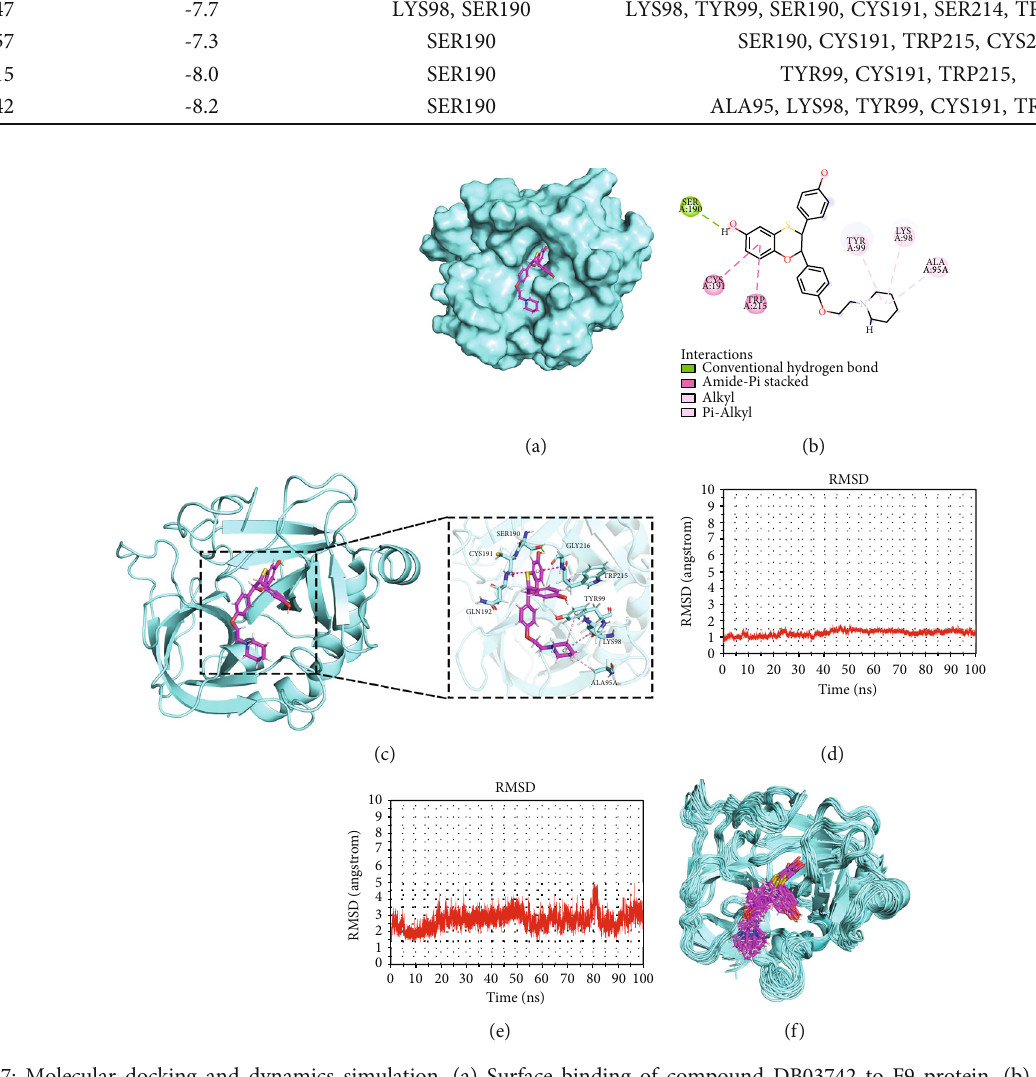
Figure 7: Molecular docking and dynamics simulation. (a) Surface binding of compound DB03742 to F9 protein. (b) 2D diagram of interaction between compound DB03742 and F9 protein. (c) 3D diagram of interaction between compound DB03742 and F9 protein. (d) RMSD of F9 protein skeleton during 100ns molecular dynamics simulation. (e) RMSF of F9 protein skeleton during 100ns molecular dynamics simulation. (f) Binding diagram of compound DB03742 to F9 protein during 100ns molecular dynamics